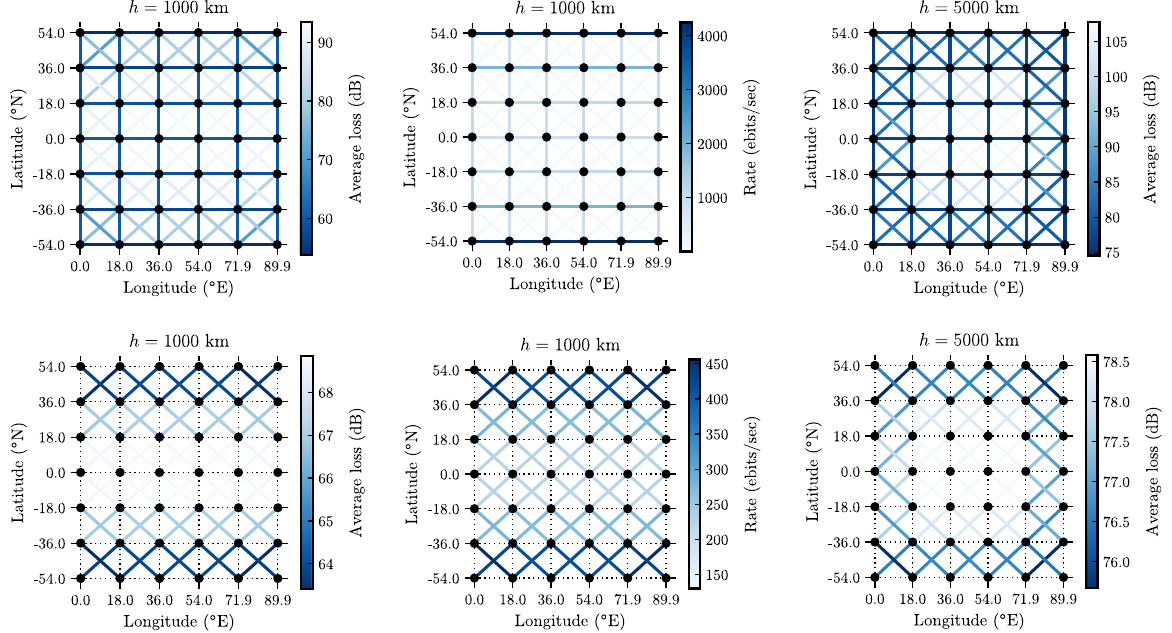
Fig. 6 Average loss and rate (over 24 h) for pairwise entanglement distribution for a collection of ground stations in a grid-like con fi guration. The nearest neighbors are separated by approximately 18° in latitude and longitude. The satellite constellation consists of N R = 15 rings and N S = 15 satellites per ring, for a total of 225 satellites. Average rates in the central panel are calculated in a simple scenario without multimode transmission from the satellites and without multimode quantum memories at the ground stations. We assume that the satellites transmit entangled photon pairs at a rate of R source = 10 9 ebits/s 100 . Top — entanglement distribution to all possible nearest-neighbor pairs. Bottom — entanglement distribution only to diagonal nearest-neighbor